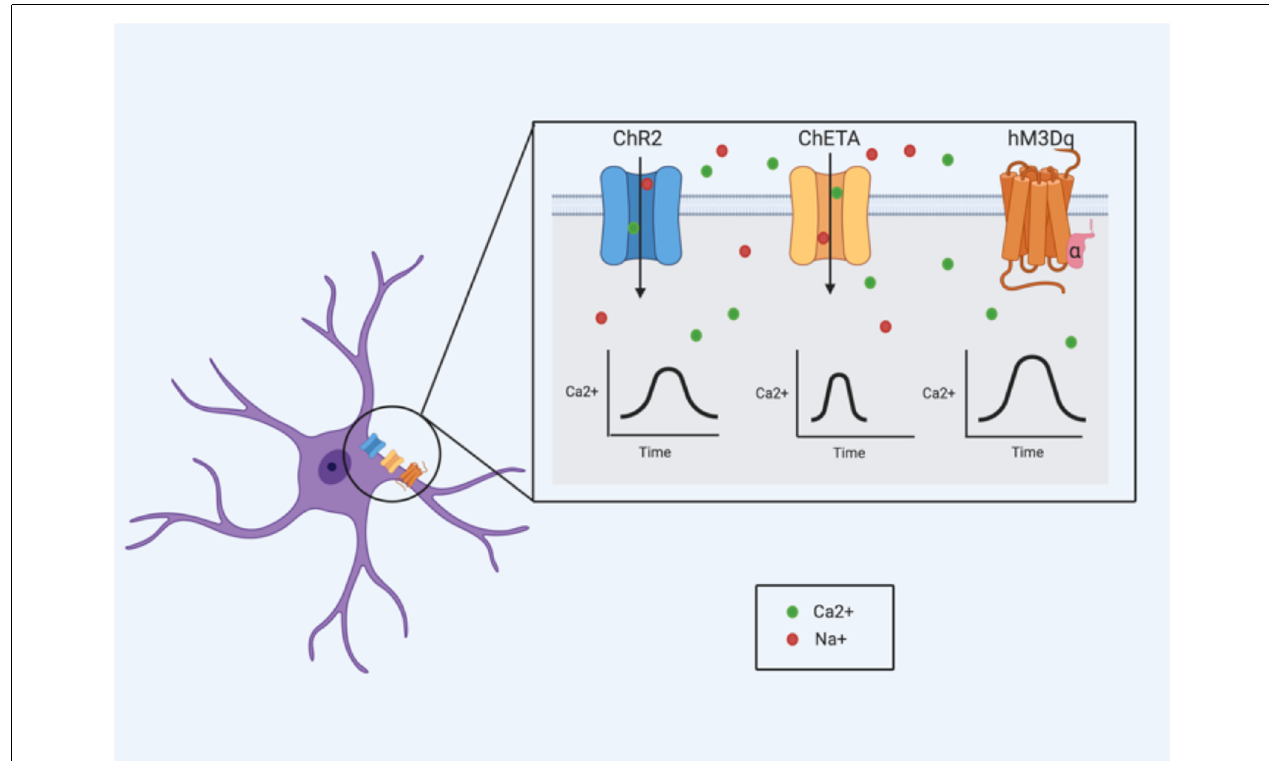
FIGURE 2 | Ca 2+ signaling dynamics are influenced by the mechanism of Ca 2+ induction. Therefore, opsin and designer receptors exclusively activated by designer drug (DREADD) variants that utilize alternative mechanisms to exert their effects may also show varying Ca 2+ responses. These ion channel or receptor kinetics need to be considered when determining the best approach for targeting an astrocyte